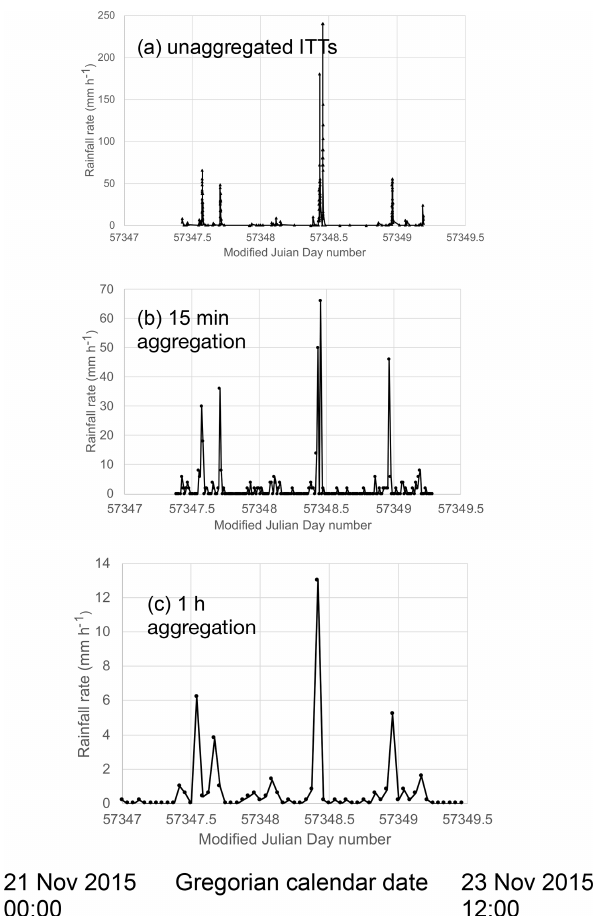
Figure 3. Effect of time aggregation on the appearance of intensity bursts in the MM data, for a rainfall event starting at Modified Julian Day 57347.42 (on 21 November 2015) and ending at 57349.24 (on 23 November 2015). (a) Unaggregated ITTs. (b) Data aggregated to 15min rainfall totals. (c) Data aggregated to 1h totals. Note that the scale of rainfall intensities differs among the three graphs, ow- ing to the more intense bursts evident in the less aggregated data. Gregorian dates for the endpoints of the date axis are shown at the bottom of the figure.